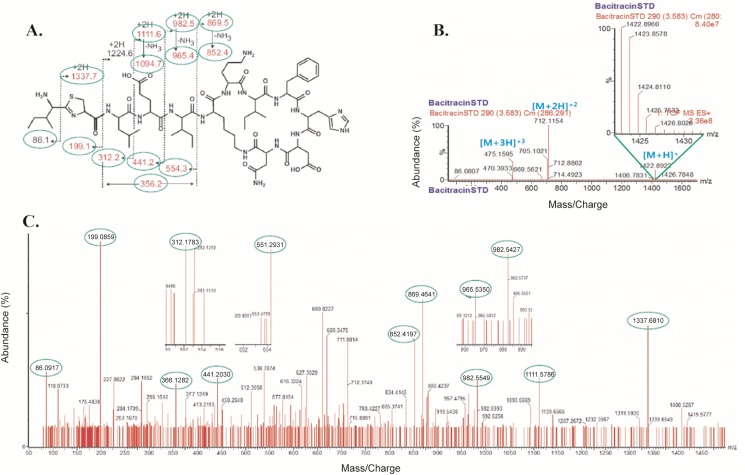
Chemoinformatic analysis of bacitracin A.(A) Standard structure of bacitracin A; (B) fragmentation patterns and percentage of abundance of standard bacitracin A and (C) of CSP32.